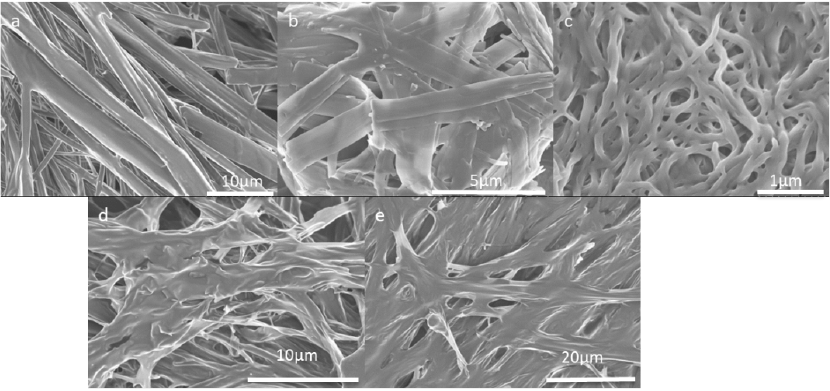
Figure 2. The FESEM imagines of xerogels 1 from different solvents: ( a ) DMF, ( b ) DMSO, ( c ) ethanol, ( d ) 1,4-dioxane, ( e )